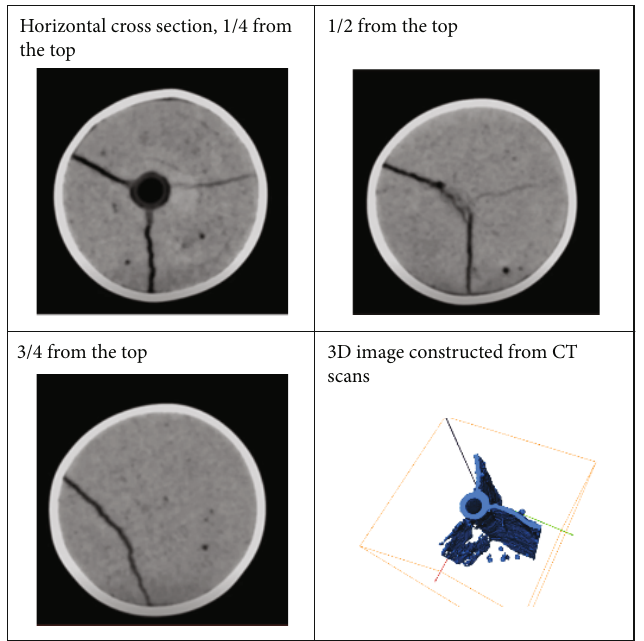
Figure 5: CT scan images showing discrete tensile fractures. Sample